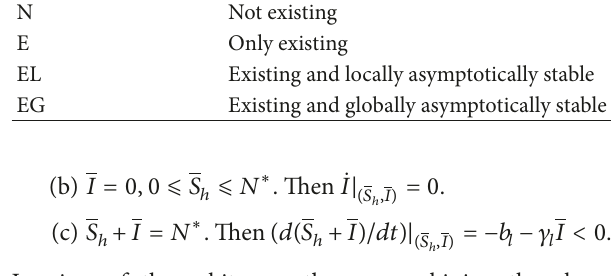
Table 1: Related instructions. N Not existing E Only existing EL Existing and locally asymptotically stable EG Existing and globally asymptotically